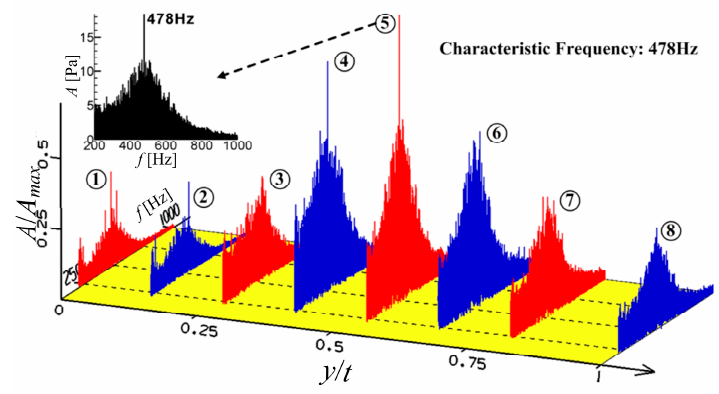
Figure 24. Frequency spectrum distribution in width direction.